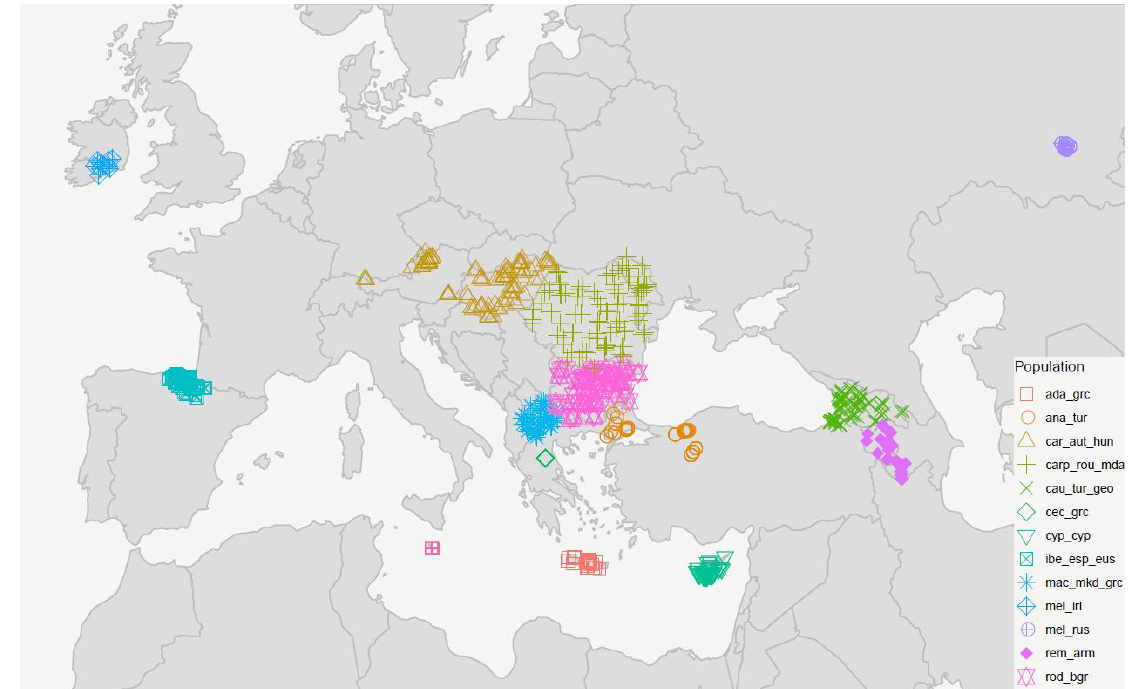
Figure 1. Sampling locations in Europe and adjacent regions plotted in R using ggplot2. M-lineage: